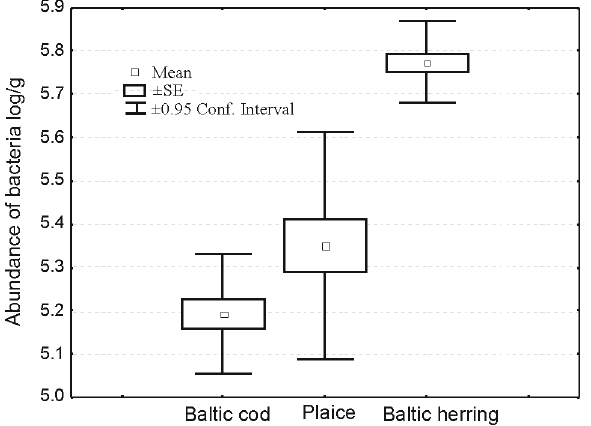
Fig. 2. Abundance of hydrocarbon-degrading bacteria in the intestinal tract of fish from the Baltic